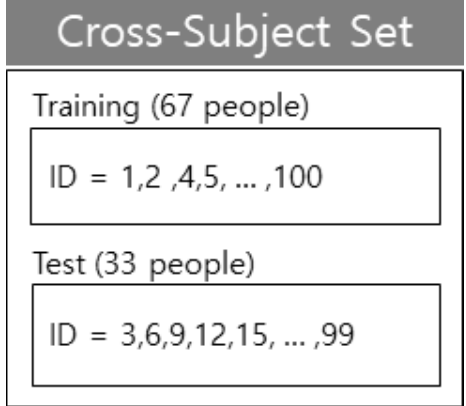
Figure 15. Composition of the CS set in ETRI-Activity3D.